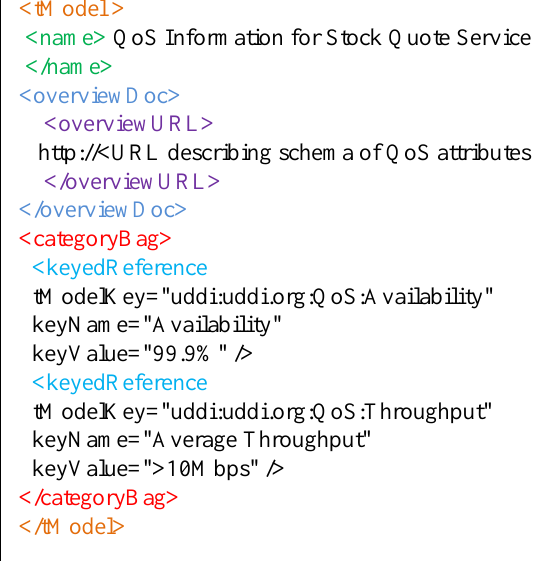
Figure 3 . tModel data of a Sample